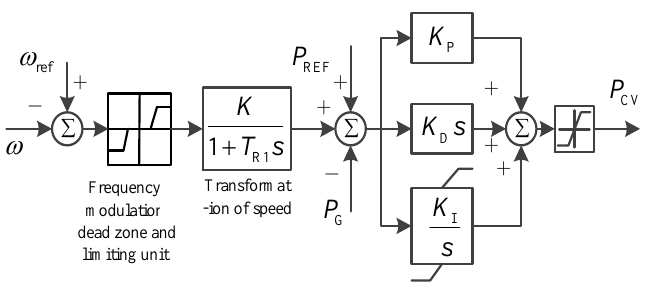
Figure 4. System diagram of governor model. ω is the generator speed unit. K is the proportional coefficient. T R1 is the measurement inertia time constant. K P , K I and K D are the proportional, integral and differential coefficients, respectively.